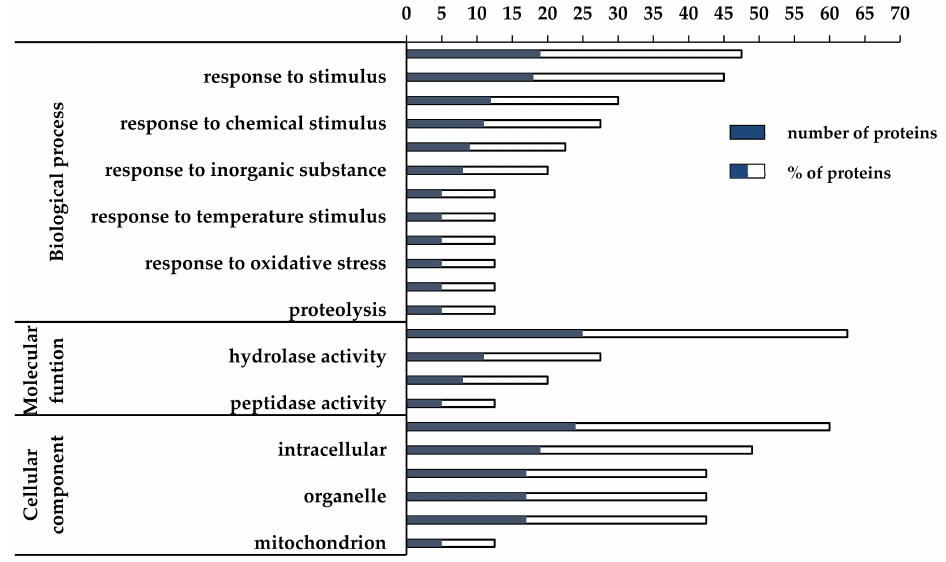
Figure 3. GO functional classification of the upregulated DEPs. The blue bar represents the number of upregulated proteins included in each GO term, whereas the sum of the blue and white bars represents the corresponding protein percentage.